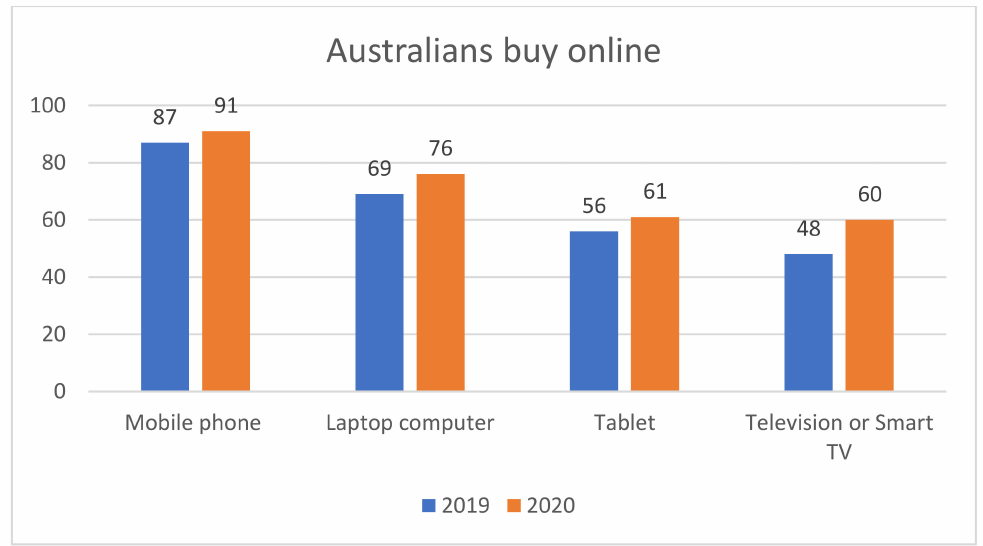
Figure 2. How Australians buy